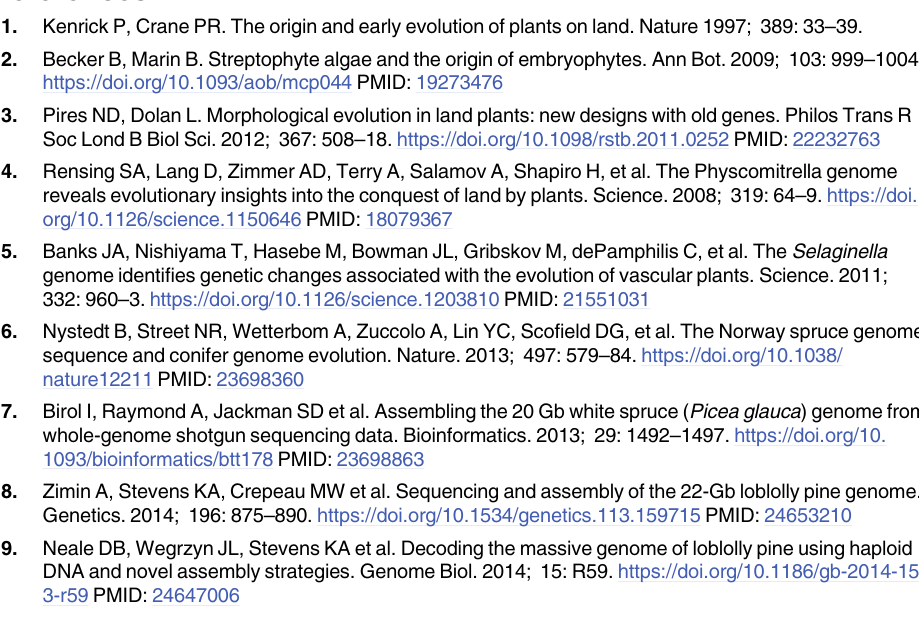
S1 Table. Statistics of sRNA libraries. S2 Table. P minima putative 5p and 3p miRNAs duplexes.